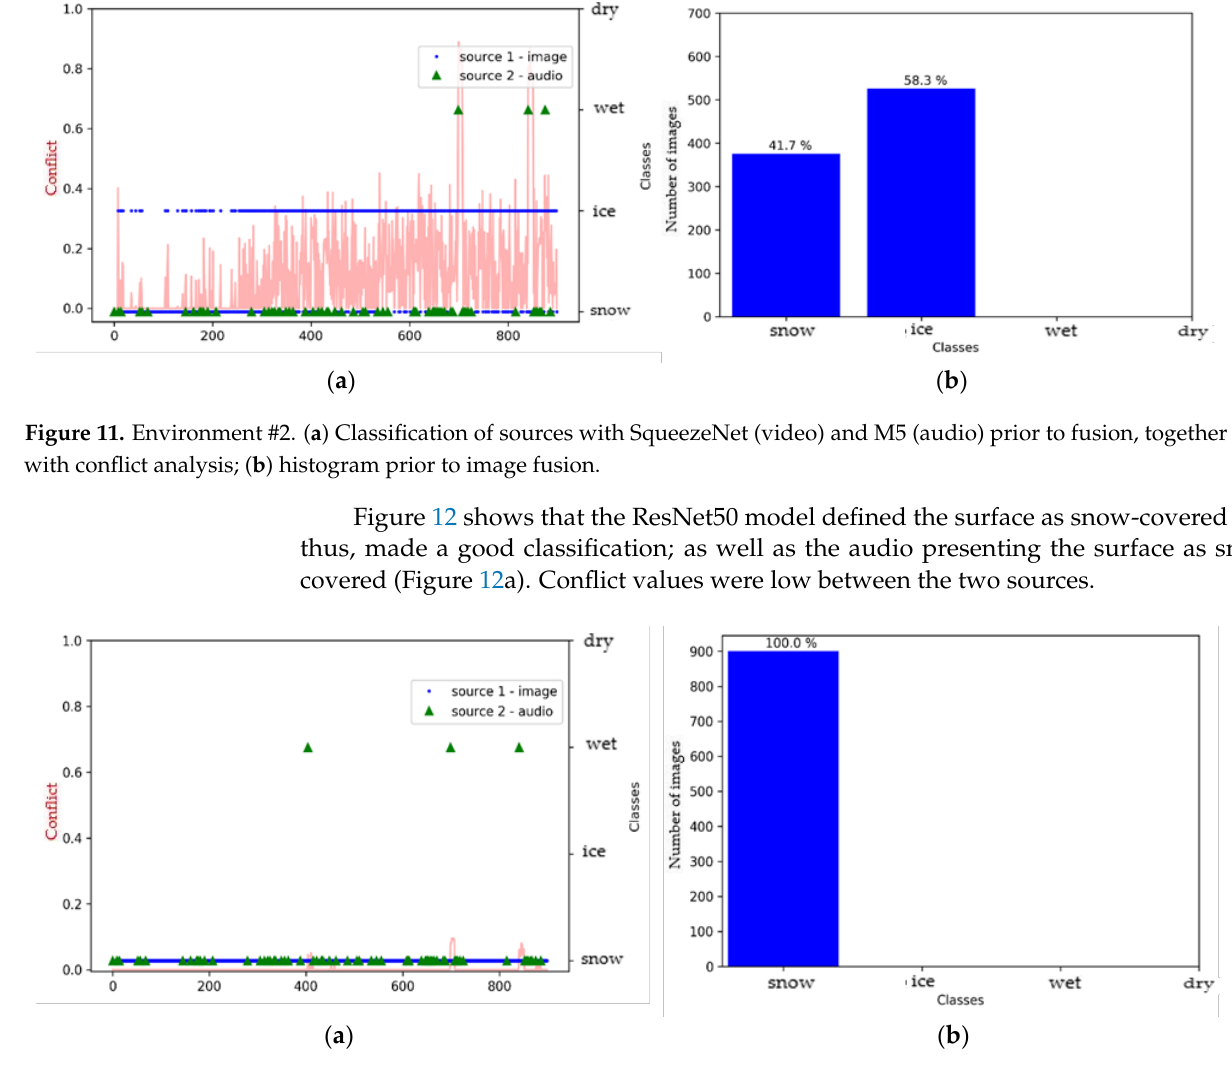
Figure 10. Environment #1. Histogram fusion results with: ( a ) Squeezenet + M5 models; ( b ) ResNet50 + M5 models; ( c ) MobileNetV3_small + M5 models.